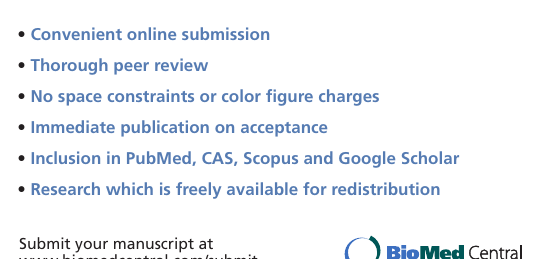
Figueiredo GM, Ximenes RA, Hepatitis Study Group: Population-based multicentric survey of hepatitis B infection and risk factor differences among three regions in Brazil. Am J Trop Med Hyg 2009, 81 (2):240 – 7.